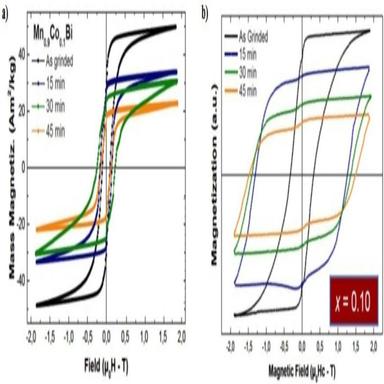
.a) Hysteresis loops of Mn0.9Co0.1Bi powder for various ball milling times, from 0 to 45 min, b) Hysteresis loops of the same orientated samples.